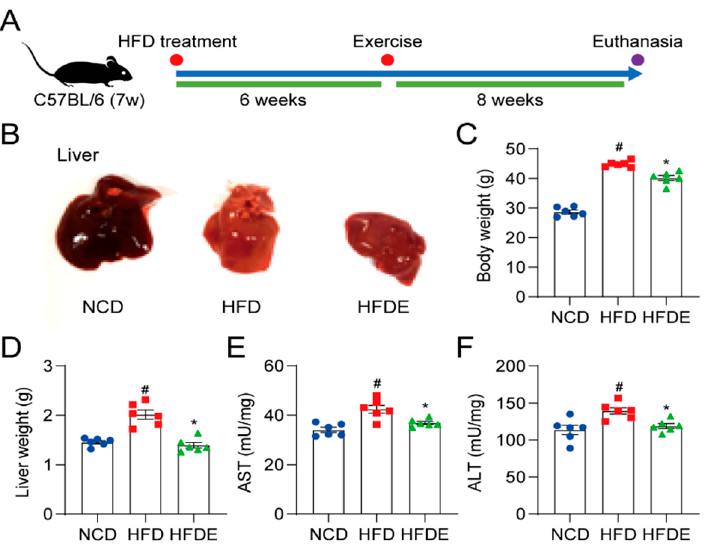
Figure 1. Liver gross appearance, body weight, liver weight, and liver enzymes in mice. ( A ) The NAFLD experimental C57BL/6 mouse model was generated according to the schematic timeline. ( B ) After sacrifice, the gross liver appearance was imaged. ( C , D ) The body weight ( C ), as well as the liver weight ( D ) was recorded. ( E , F ) Liver damage was assessed by measuring the hepatic levels of AST ( E ) and ALT ( F ). The data are presented as the mean ± SEM, n = 6 per group. # p < 0.05 vs. NCD group; * p < 0.05 vs. HFD group.